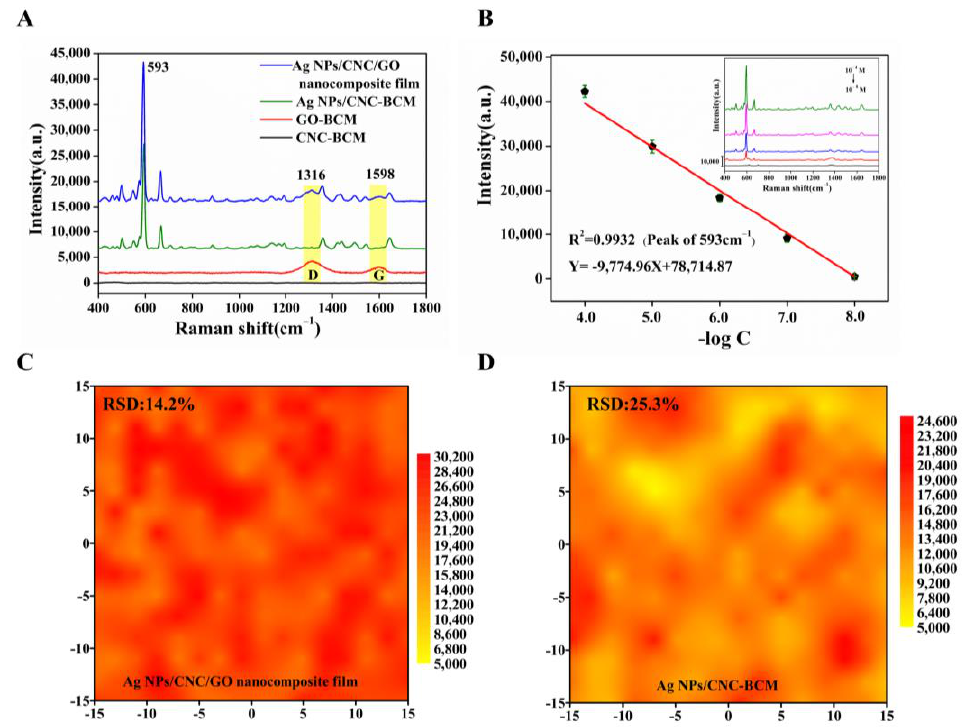
Figure 4. We characterized the SERS performance of our synthesized Ag NPs/CNC/GO nanocom- posite film using a 785 nm laser integrated at 15 mW laser power for 10 s. ( A ) SERS spectra of NBA (10 − 5 M) adsorbed on CNC-BCM, GO-BCM, Ag NPs/CNC-BCM and Ag NPs/CNC/GO nanocompo- site film. ( B ) Linear curve of 593 cm − 1 SERS intensity versus concentration for NBA adsorbed on Ag NPs/CNC/GO nanocomposite film, inset indicates SERS spectra of NBA at 10 − 4 M – 10 − 8 M. ( C , D ) were the SERS mapping plots at 593 cm − 1 of the SERS spectra of Ag NPs/CNC/GO nanocomposite film and Ag NPs/CNC- BCM in 30 μm × 30 μm arrays with 10 − 5 M NBA adsorbed, respectively.